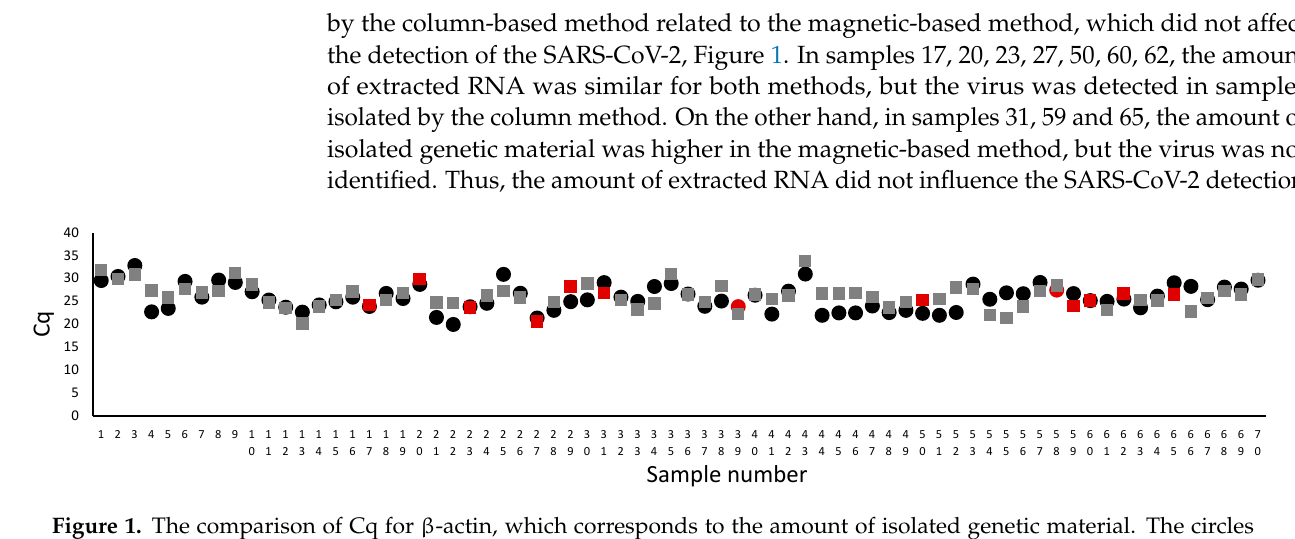
Figure 1. The comparison of Cq for β -actin, which corresponds to the amount of isolated genetic material. The circles represent the magnetic-based, while squares column-based RNA extraction method. The Cq mean for the column-based method was 25.82 +/ − 2.8, while from the magnetic-based method 26.17 +/ − 2.7 (n = 70, p = 0.44, the comparison was made by one-way ANOVA, followed by the Bonferroni-Holm post hoc test). The red marker shows the sample for which the SARS-CoV-2 was detected only in RNA extracted by one method (samples 17, 20, 23, 27, 29, 31, 39, 50, 58, 59, 60, 62, and 65; red indicates positive, while the standard color is negative). Samples were analyzed with MutaPlex kit.